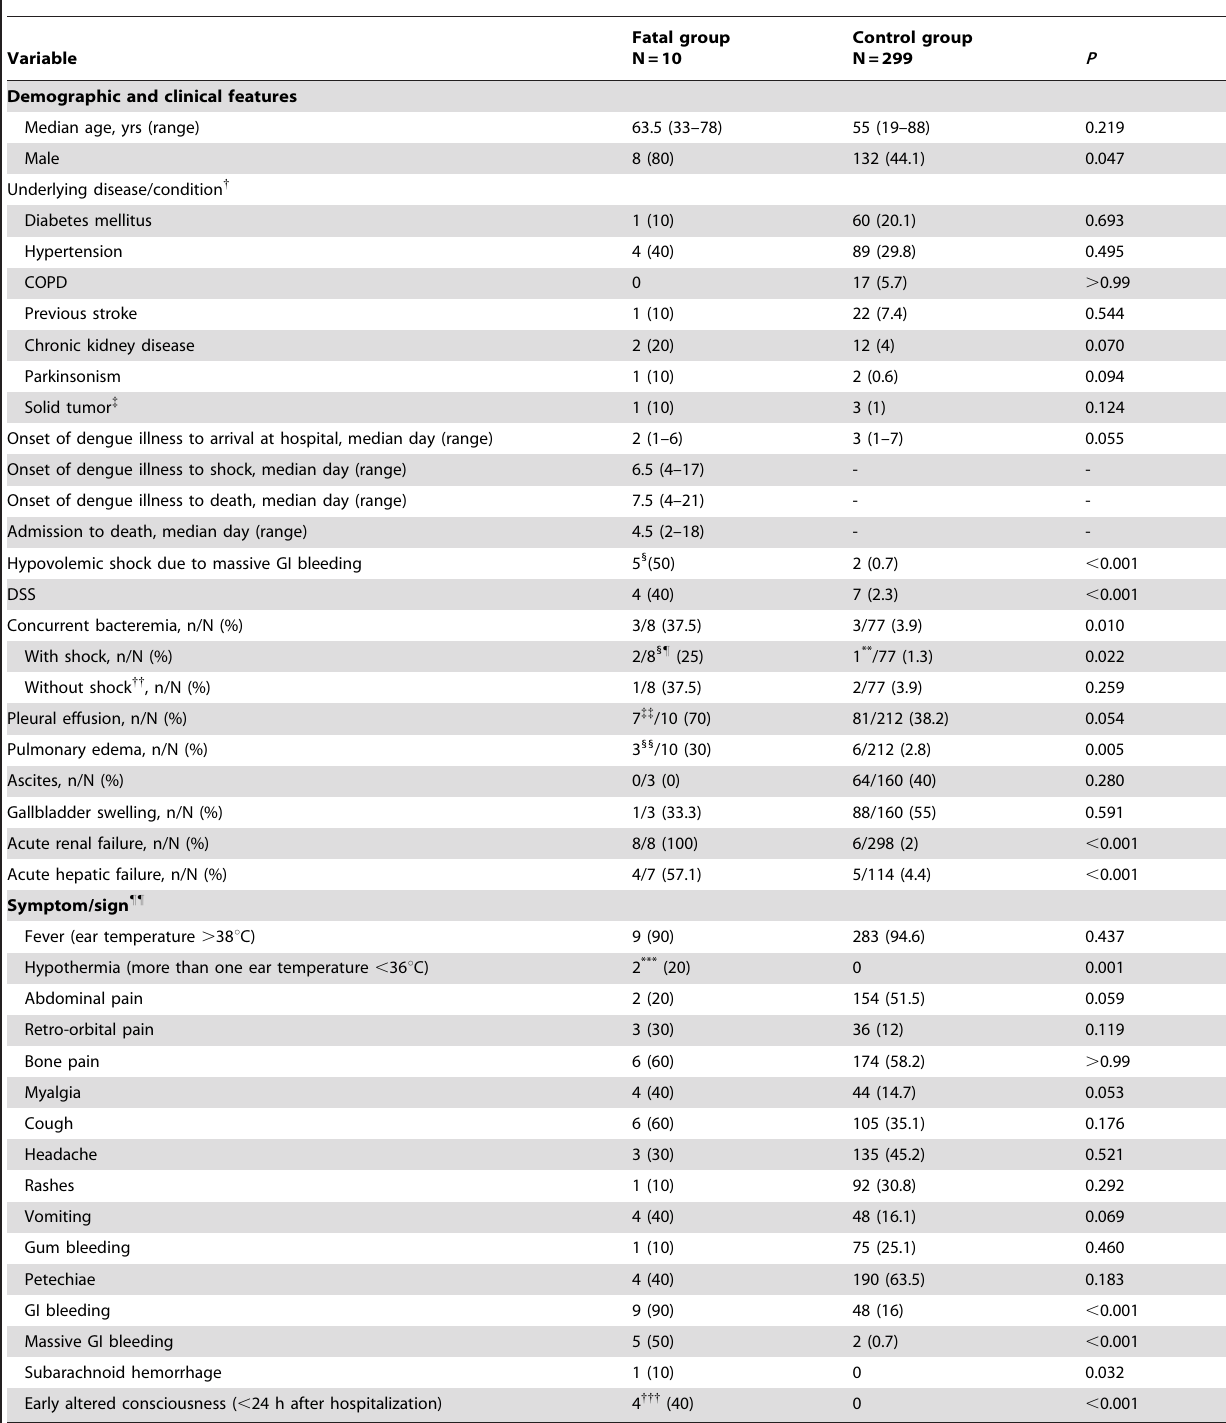
Table 1. Demographic and clinical information of the fatal and control groups *